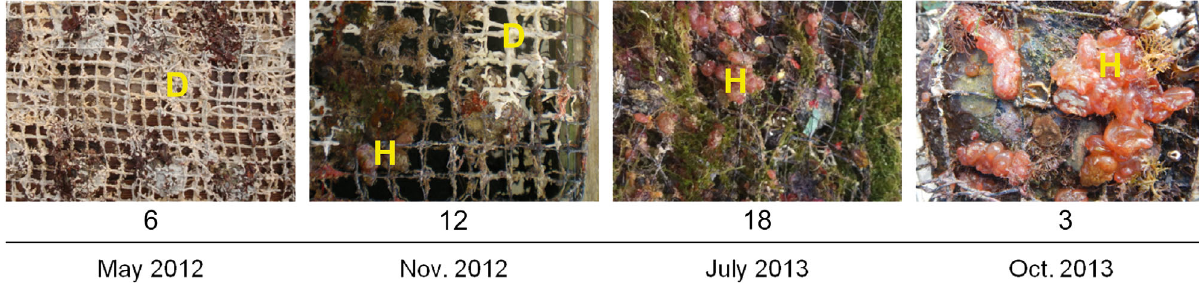
Fig. 2. Patterns of change over time of the epibiont colonization on pearl oyster Pinctada margaritifera nets in Mangareva. Numbers indicate the duration (in months) of the colonization by epibionts at each sampling date. Note: Colonization was interrupted in July 2013 after the nets were accidentaly cleaned by the farmer (see ‘Materials & methods’). D: Didemnum sp. H: Herdmania momus Table 1. Food sources for pearl oysters Pinctada margaritifera and ascidians in ambient water. Concentrations of particulate organic carbon (POC) and nitrogen (PON) and carbon:nitrogen ratio (C:N) for the 2 size classes of POM at the 2 sites and for the different sampling dates (n = 3, mean ± SD) are given. –: data excluded because of contamination of the